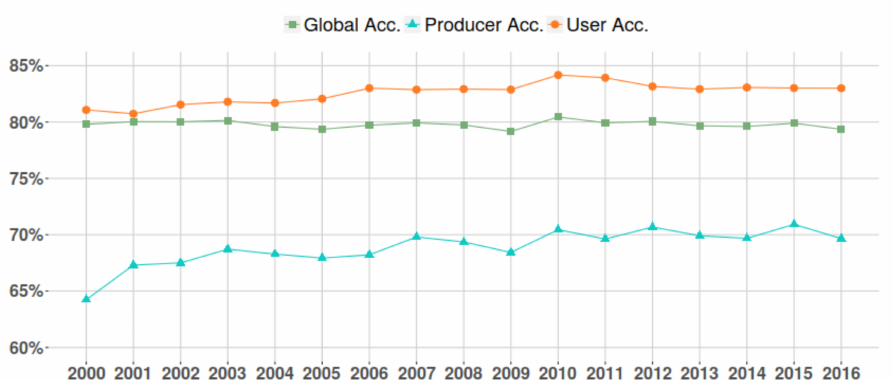
Figure 4. The accuracy assessment of the Brazilian pastureland mapping, considering 5000 random points, was inspected by five interpreters who considered 34 Landsat overpasses (two images per year), the NDVI-MOD13Q1 time series and high-resolution Google Earth images.